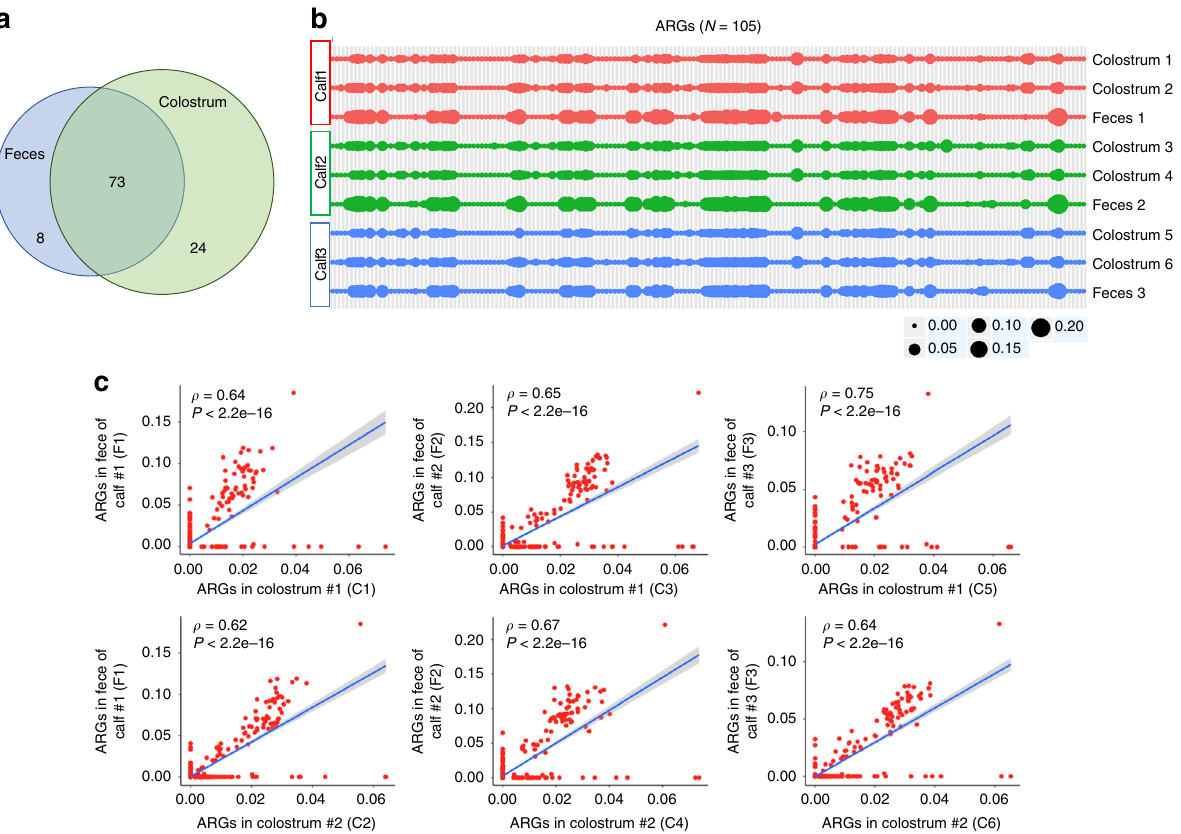
Fig. 6 The vertical transmission of ARGs from colostrum to dairy calves. a Venn diagram showing shared ARGs between colostrum and day 2 fecal samples. b The presence of 105 normalized ARG groups (per AMR + + pipeline) was denoted as dots in colostrum and day 2 fecal samples, the size of dots indicates abundance, and the color of lines indicates animals. c Spearman ’ s rank correlation coef fi cient was calculated to study the correlation of ARG- patterns in paired colostrum and fecal samples. C represented colostrum sample, F indicated fecal sample; two colostrum samples and one fecal sample were collected per calf for this analysis, numbers were added to distinguish samples across animals. Source data are provided as a Source Data fi